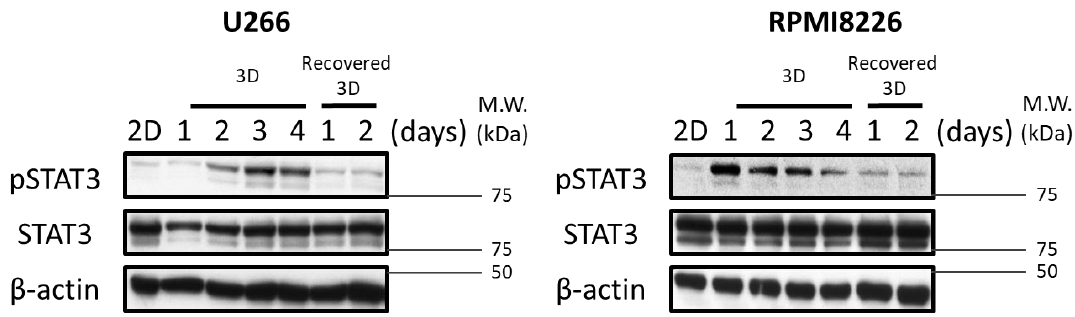
Figure 3. Acquired STAT3 activity in MM cells diminished upon transfer from 3D to conventional culture. The STAT3 activity in U266 and RPMI8226 cells before and after transfer from 3D culture by Western blot analysis of pSTAT3 level. U266 and RPMI8226 were pre-cultured in 3D culture for 2 days and 1 day prior to transfer to reach a substantial pSTAT3 level, respectively. β -actin was probed as a loading control. 2.5 × 10 5 cells were seeded initially.